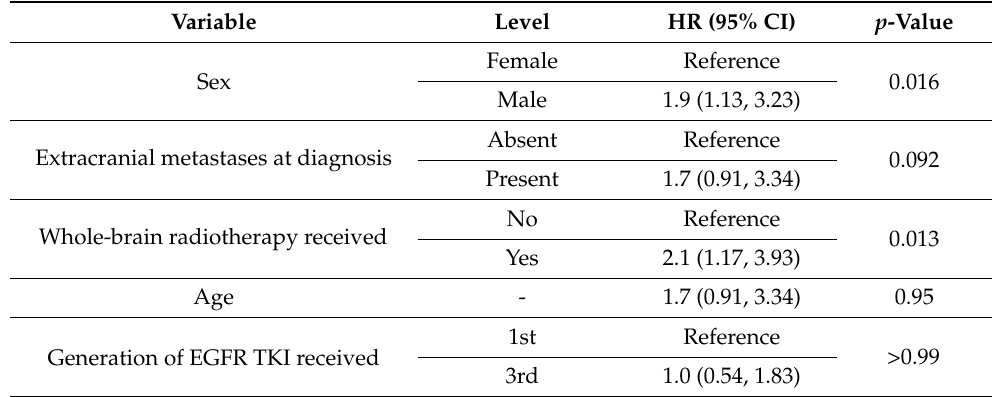
Table 10. Multivariable Cox-Proportional Hazards Modelling of progression-free survival (PFS)